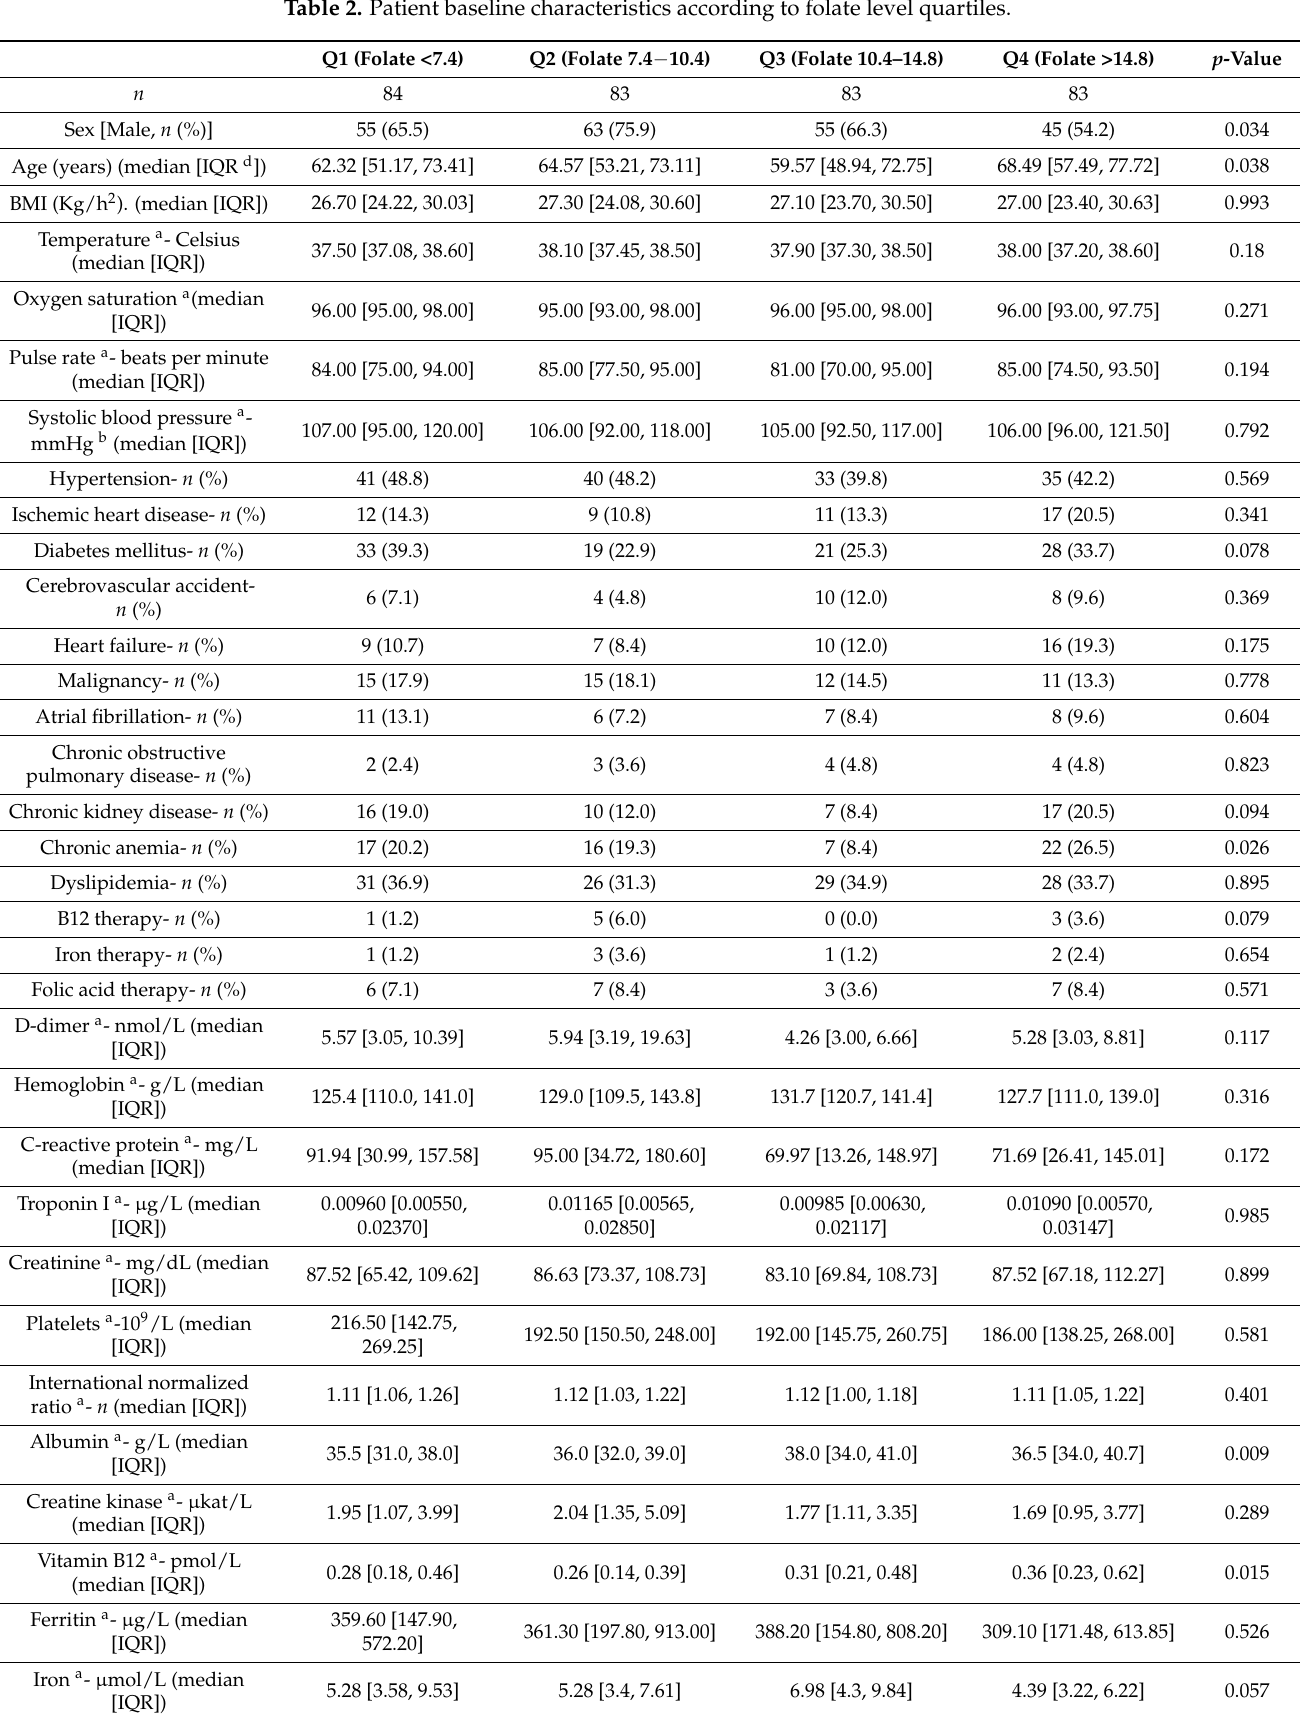
Table 2. Patient baseline characteristics according to folate level